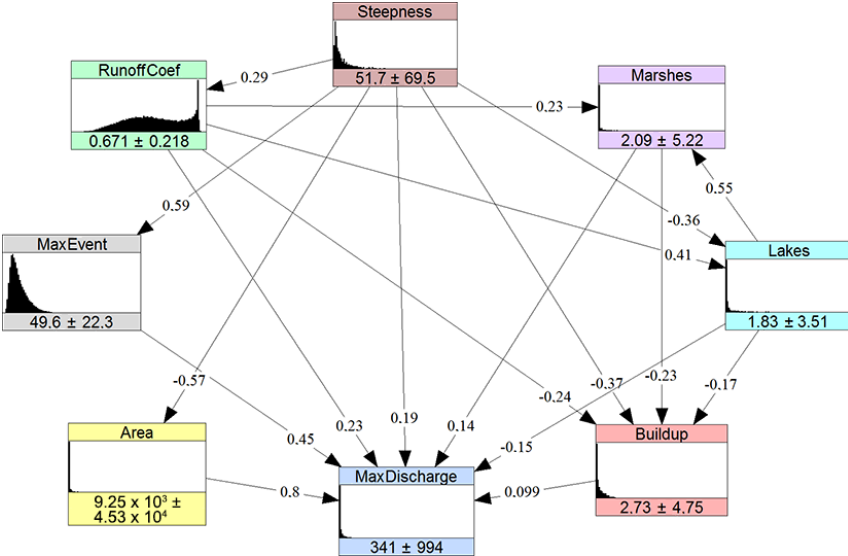
Figure 3. Bayesian network for river discharges in Europe. The nodes are presented as histograms, with numbers indicating the means and standard deviations of the variables. Values on the arcs are the (conditional) rank correlation